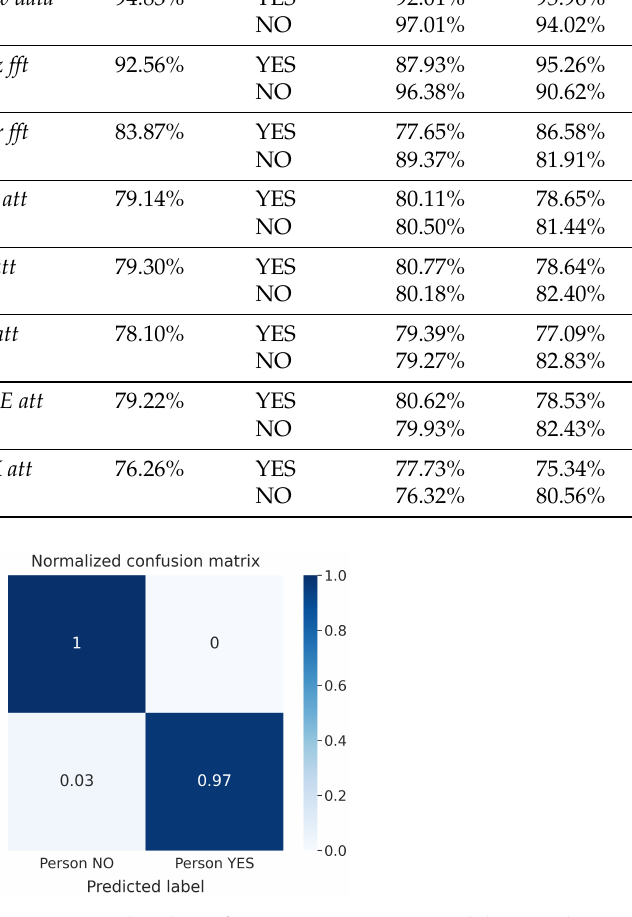
Figure 8. Normalized Confusion Matrix LSTM model—raw data, static